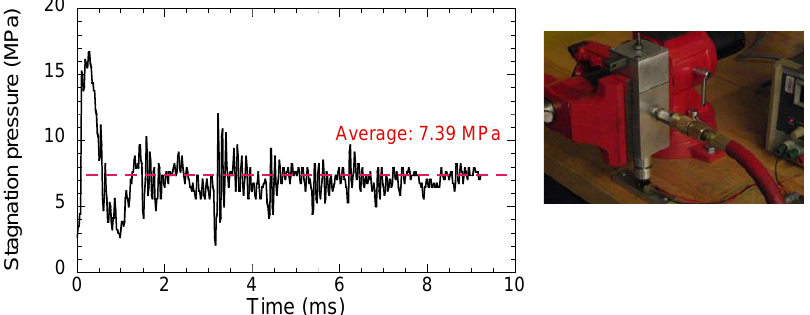
Figure 5. A picture of the in-house air-powered injector and sample pressure trace taken from the air-powered injection experiment [18] with a driving pressure of 413 kPa and orifice nozzle diameter of 200 m. The pressure was obtained using a different force sensor (Honeywell FSG15N1A).